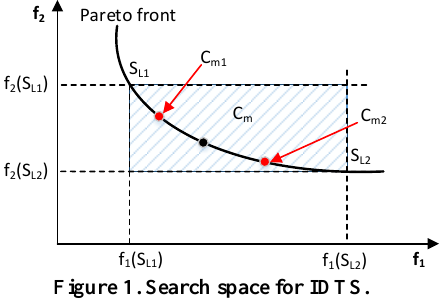
Figure 1. Search space for IDTS.